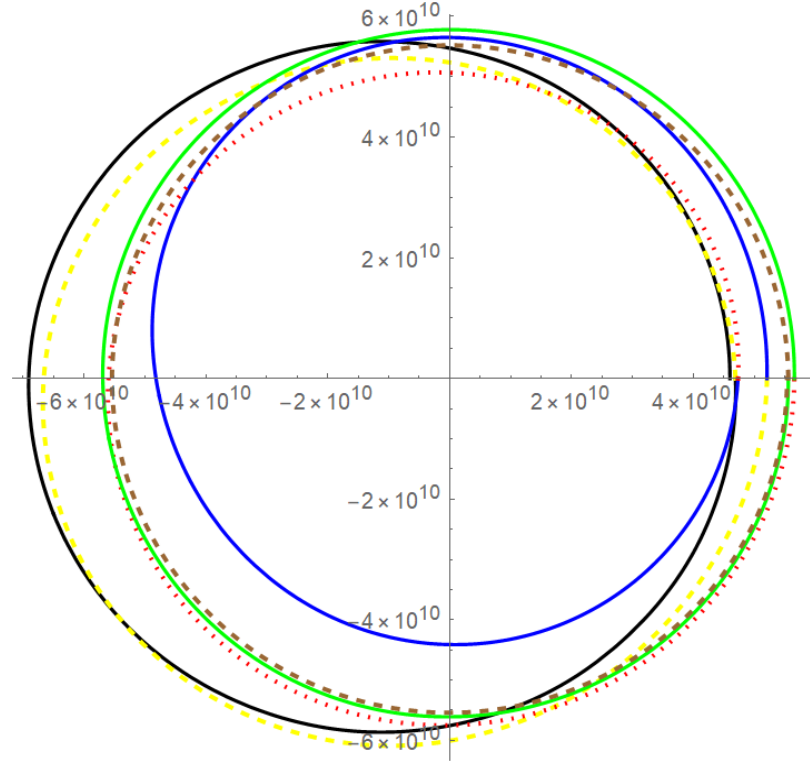
− 43 Λ = Λ + = 2.57 × 10 = 2 : 57 10 (cid:0) 43 : (93) Figure 3. Mercury’s trajectory using Ode (28) with + (cid:2)